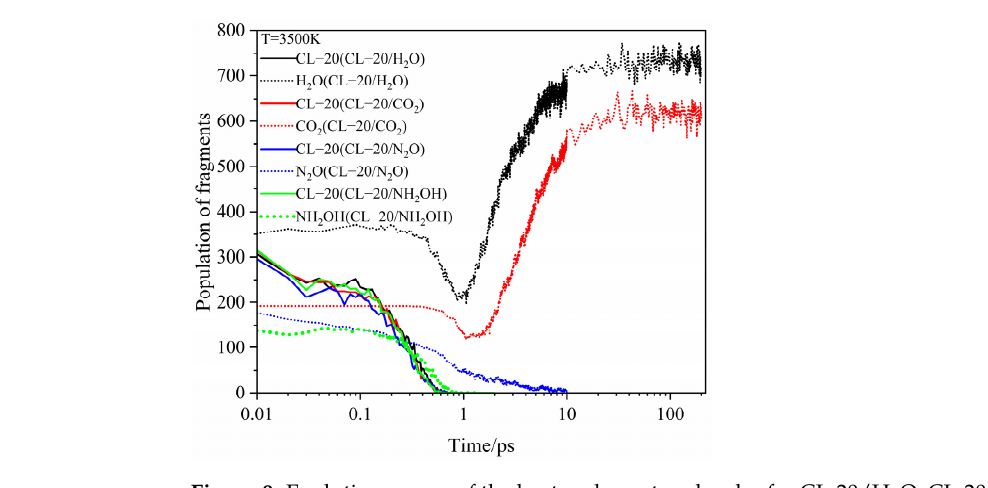
Figure 9. Evolution curves of the host and guest molecules for CL-20/H 2 O, CL-20/CO 2 , CL-20/N 2 O, CL-20/NH 2 OH at 3500 K. Thick trendline corresponds to the actual concentration data of corresponding matching color.